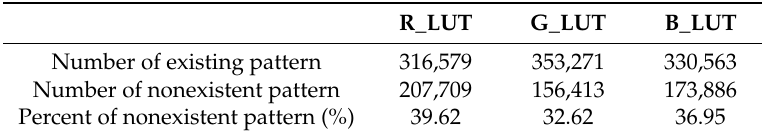
Table 1. A case of designed